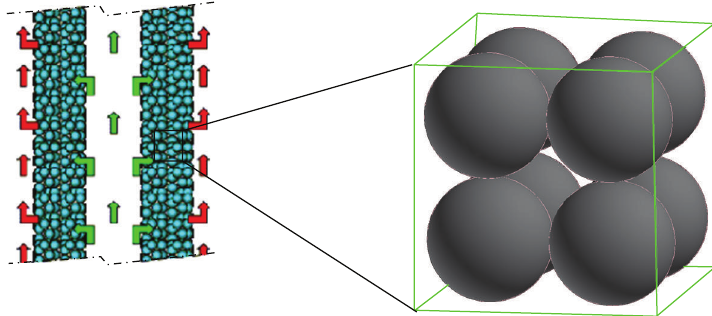
Figure 2: Basic GCFR core cell (Simple Cubic, SC).